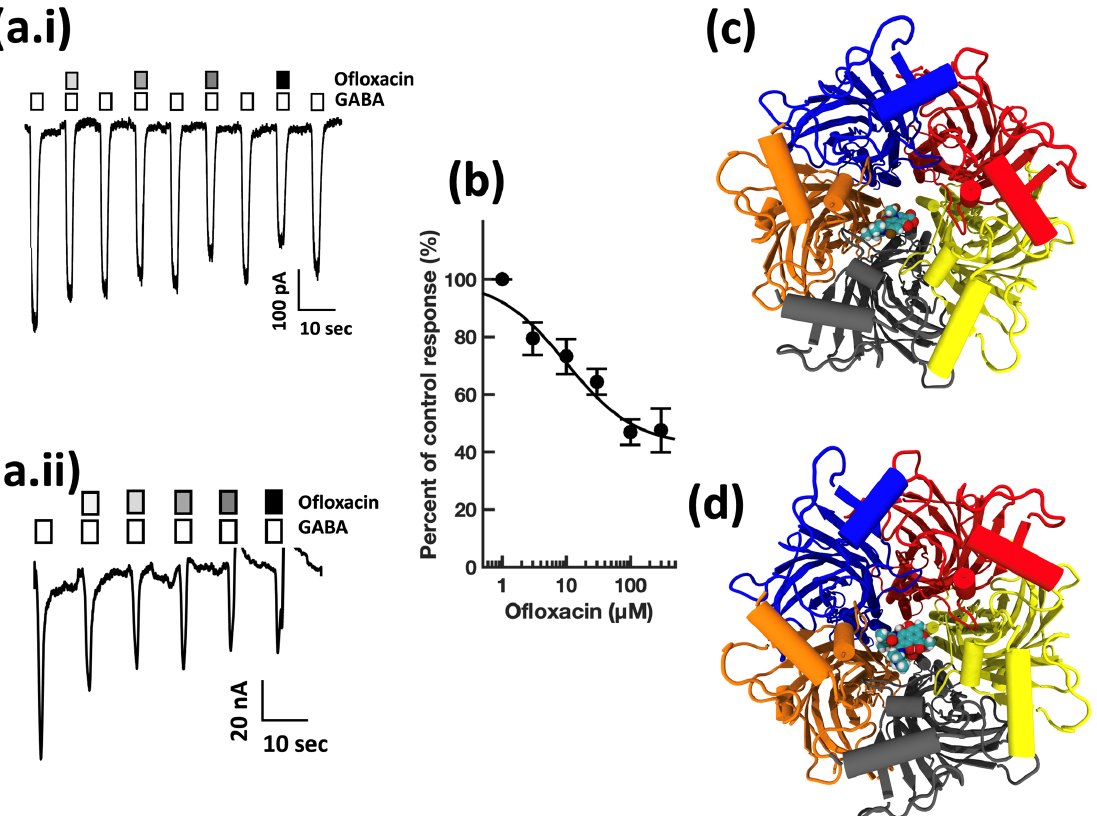
Figure 4. Pentylenetetrazole inhibits GABA A receptor activation in a concentration-dependent man- ner, and preferentially docks at the γ + β Interface in a pocket defined by canonical loops A-E. ( a ) Representative microfluidic ensemble whole cell recording from HEK293 cells expressing rat α 1 β 2 γ 2s GABA A receptors. Open bars above the current trace indicate the duration of GABA appli- cation. Shaded bars indicate the duration of pentylenetetrazole application. Darker shading indi- cates increased concentration. The concentrations applied were 1, 3, 10, 30, and 100 μ M pentylene- tetrazole. Calibration bars indicate current amplitude, and duration in nA and seconds. ( b ) Pen- tylenetetrazole concentration response relationship for GABA receptor modulation. Each point is plotted as mean ± standard error of the mean for 20–24 determinations. ( c ) The pentylenetetrazole binding pocket is predicted to be defined by the γ (loops D and E) and β (Loops A, B, and C) subu- nits. Color key: α subunit (red and grey), β subunit (yellow and orange), γ subunit (blue).